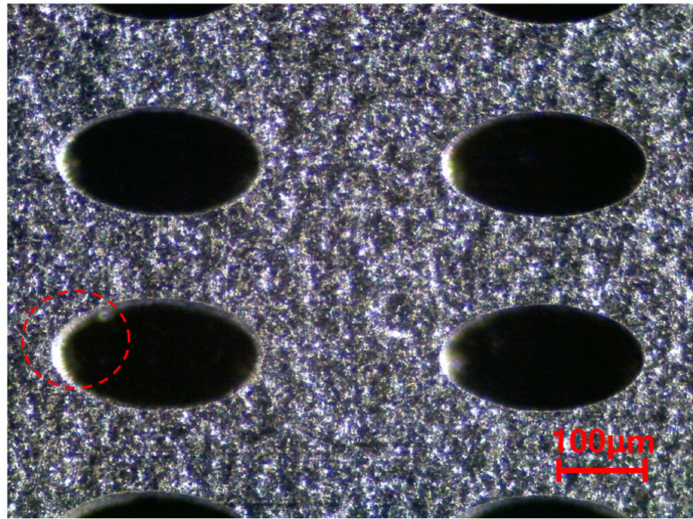
Figure 17. The shape of imperfect